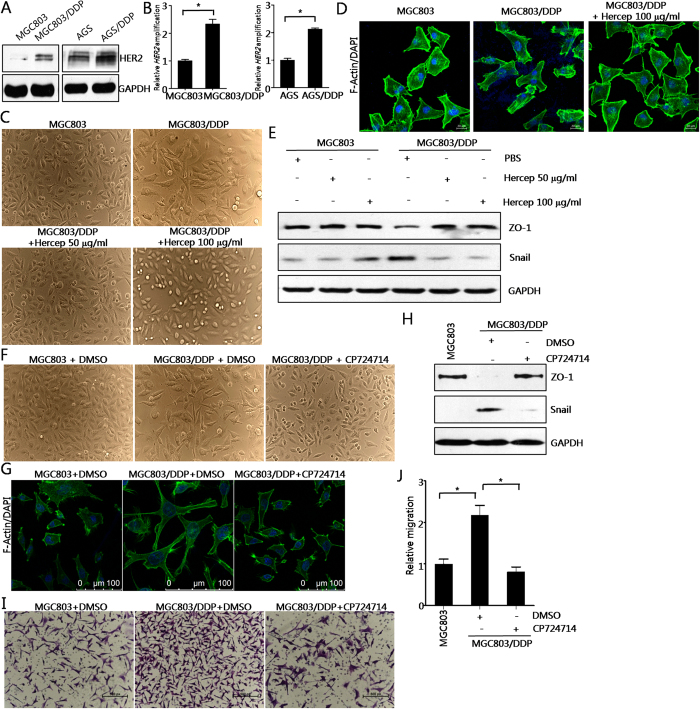
HER2 is overexpressed and both Herceptin incubation and siRNAs against HER2 reversed the EMT in cisplatin-resistant gastric cancer cells.(A) Western blot of HER2 in MGC803/DDP and AGS/DDP cell lines, and parental MGC803 and AGS cells. GAPDH was used as loading control. (B) Relative amplification of HER2 in parental and cisplatin-resistant cells. Results were presented as the mean ± SD of two independent experiments, *P < 0.05 compared with parental cells. (C) Herceptin incubation abrogated EMT morphology in MGC803/DDP cells. Representative images of cellular morphology of MGC803/DDP cells, plus parental MGC803 cells treated with Herceptin for 24 h were shown. Hercep represents Herceptin. (D) Herceptin incubation reversed EMT morphology in MGC803/DDP cells. Representative images of FITC-phalloidin staining of F-actin after 100 μg/ml Herceptin treatment for 24 h were shown. (E) Effects of Herceptin on levels of ZO1 and Snail. (F) CP724714 treatment abolished EMT-like cell morphology. Cells were incubated with 10 μM CP724714 for 24 h. Representative images of cellular morphology of were captured. (G) CP724714 treatment abrogated EMT-like cell morphology. Cells were treated as in Fig. 4F, FITC-phalloidin staining of F-actin was performed and typical images were shown. (H) Effects of CP724714 on ZO1 and Snail. (I) CP724714 inhibited the increased cell migration in cisplatin-resistant gastric cancer cells. Representative images were presented here. (J) CP724714 inhibited the increased cell migration in cisplatin-resistant gastric cancer cells. Values represented the mean ± SD from three independent experiments with triplicate samples. *P < 0.01.